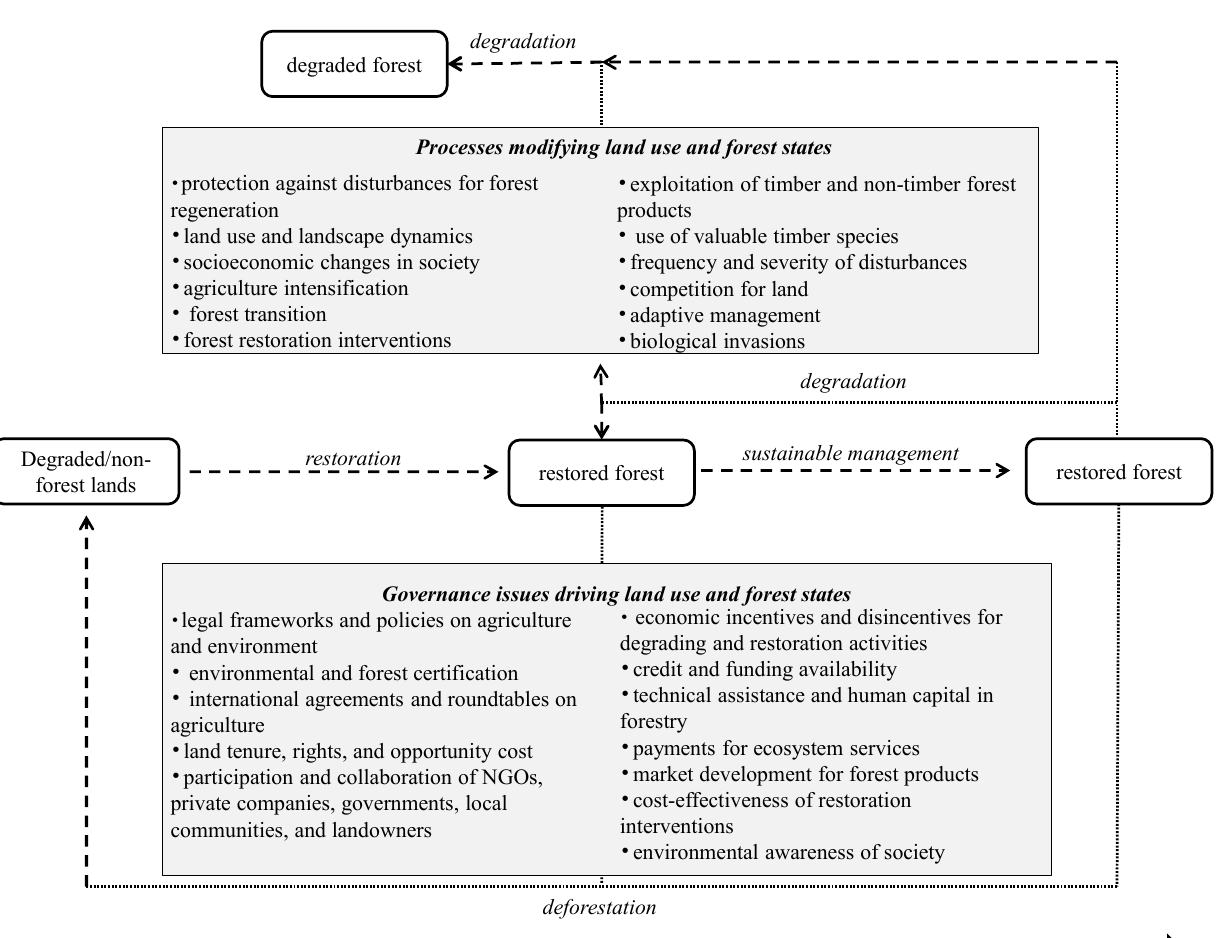
Figure 1. Key governance issues driving ecological and socioeconomic processes associated to land and forest states modification and their